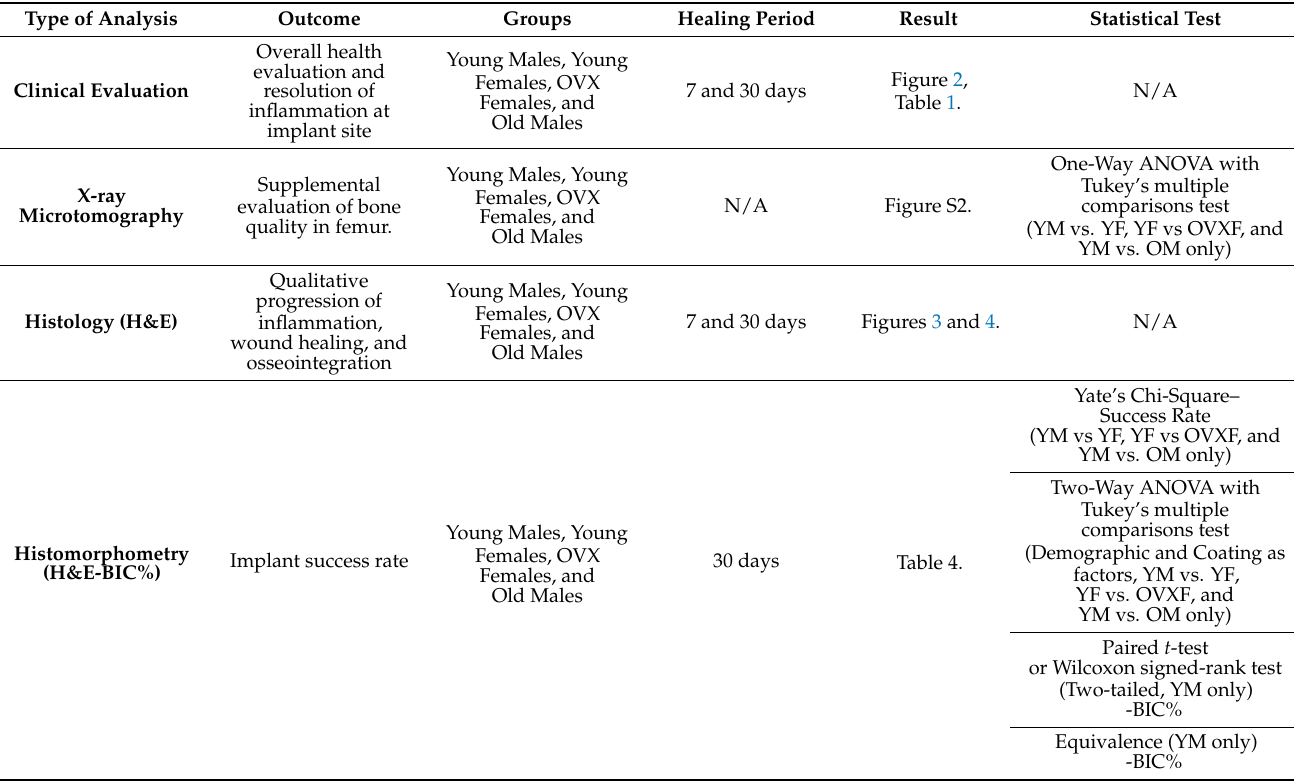
Table 2. Summary of methods used in this